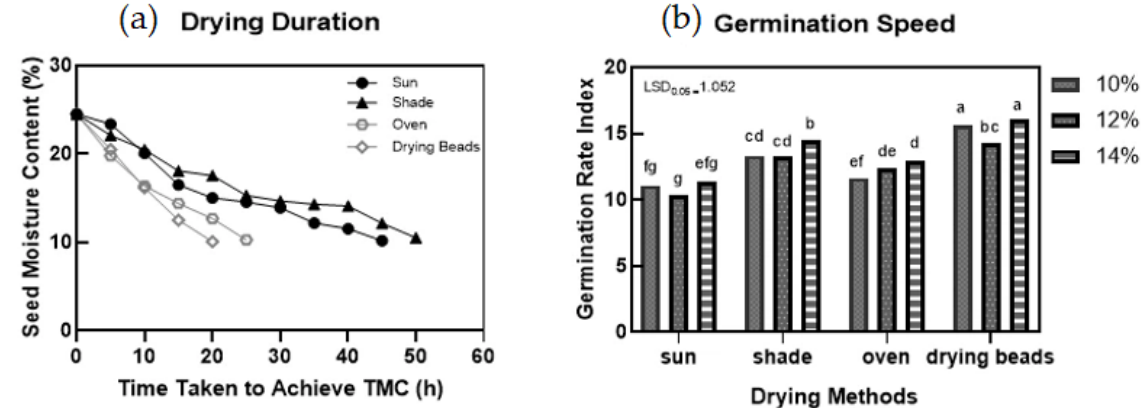
Figure 1. Effects of different drying methods (sun, shade, oven, and drying beads) on drying duration ( a ) and germination speed ( b ) of lablab bean seed. Means with same letters are not significantly